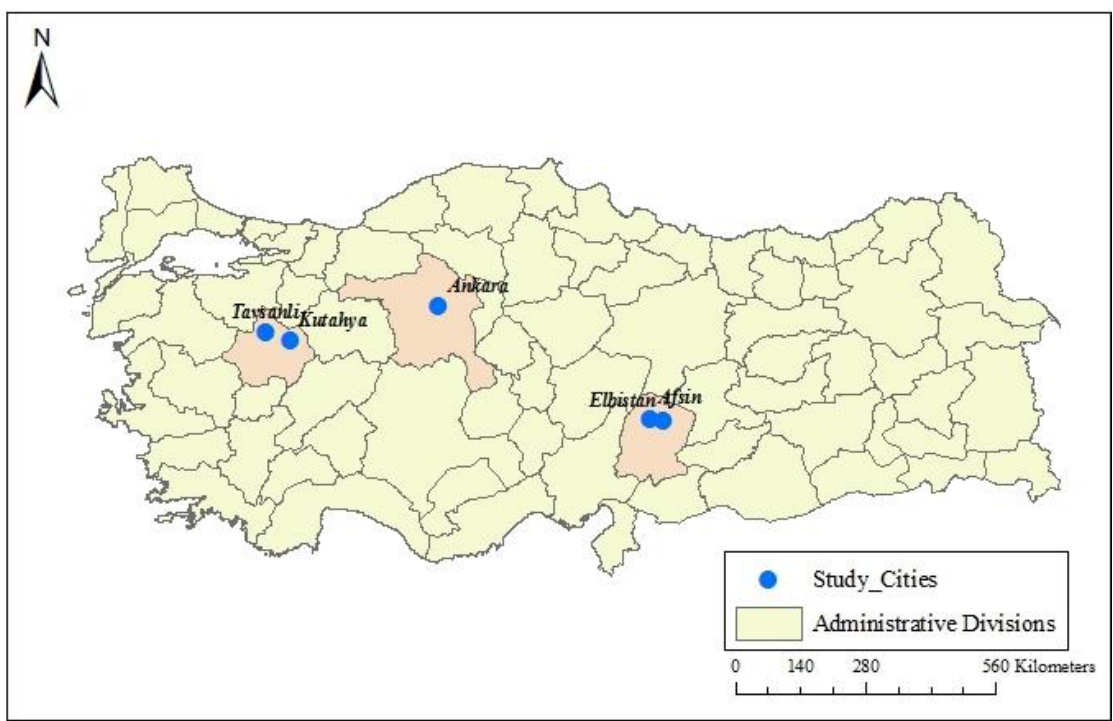
Figure 1. Geographical Location of the Study Areas in